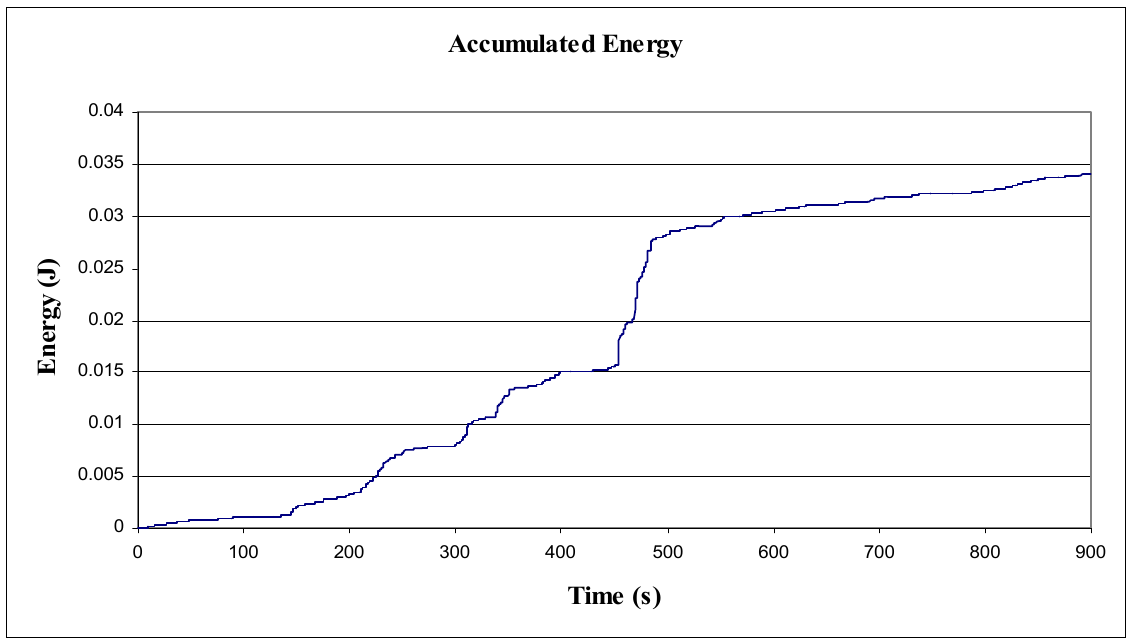
Figure 12. Accumulated Energy, E pendulum